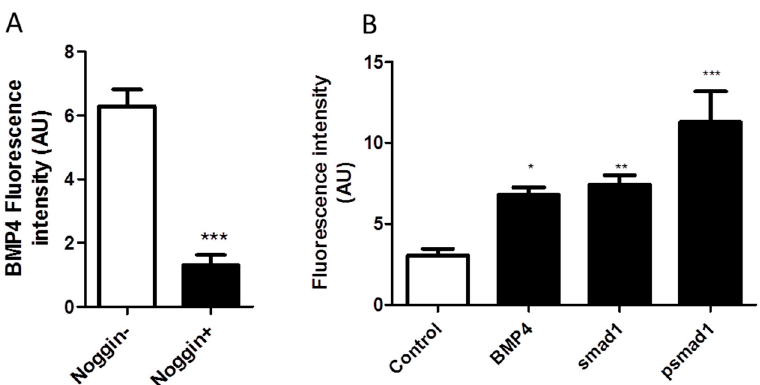
Figure 4. NO modulates BMP4-SMAD pathway in heart. ( A ) Specificity test of BMP4 antibody: Vertical sections of 4th day old chick embryonic heart were immune-stained with BMP4 antibody in two groups one pre-treated with BSA (indicated as noggin − ) and another one with BSA+ Recombinant noggin (indicated as noggin +). Relative fluorescence intensity measurements using Adobe photoshop expressed as arbitrary units (AU). The results are expressed as mean +/ − S.E. ( n = 3, *** p < 0.001 BSA vs. BSA+noggin by t -test). ( B ) IHC of DN treated embryos showing higher expression of BMP4, SMAD and pSMAD in heart compared to that of PBS treated embryos. Relative fluorescence intensity measurements using Adobe photoshop expressed as arbitrary units (AU). The results are expressed as mean +/ − S.E. ( n = 3, * p < 0.05, ** p < 0.01, *** p < 0.001 PBS vs DN by one-way ANOVA).